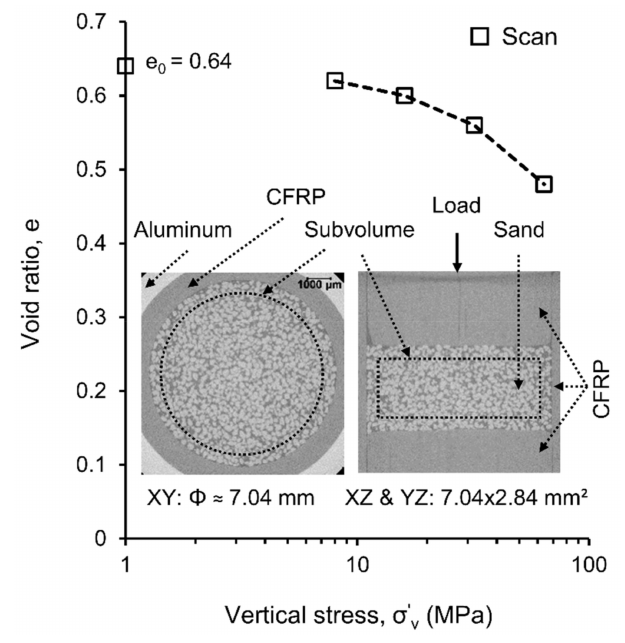
Figure 1. e-log σ ’ v plot for the specimen consisting of RBS particles tested under one-dimensional compression ( Φ : diameter; e 0 : initial void ratio; CFRP: carbon fiber reinforced